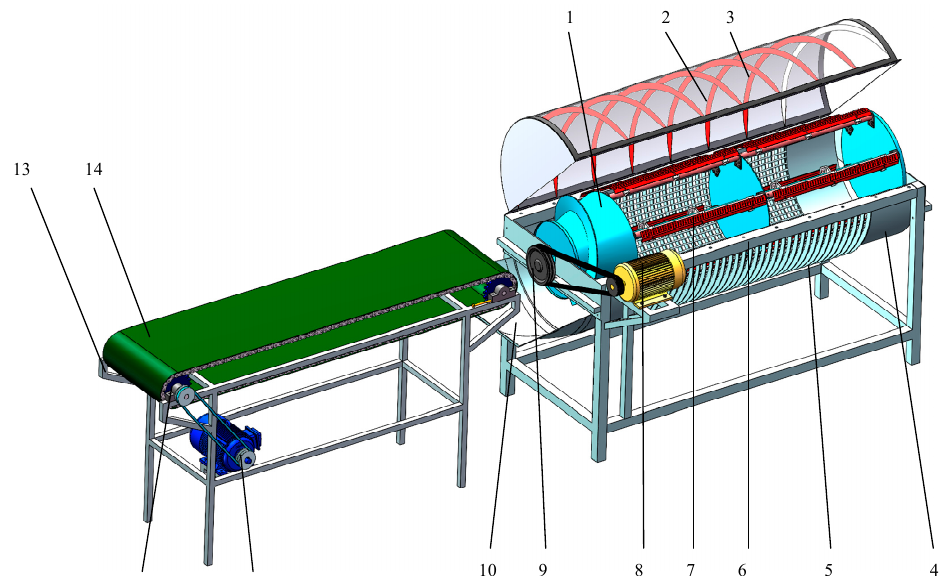
Figure 1. Three-dimensional model of the threshing test bench: 1. feeding head; 2. upper cover; 3. deflector; 4. plate for impurity removal; 5. gravure screen; 6. rack; 7. threshing rasp bar; 8. drive motor; 9. pulley; 10. feed inlet; 11. transmission device motor; 12. sprocket; 13. conveyor frame; 14. conveyor belt. Table 1. Parameters of equipment used in the threshing test bench. Parameter Striped